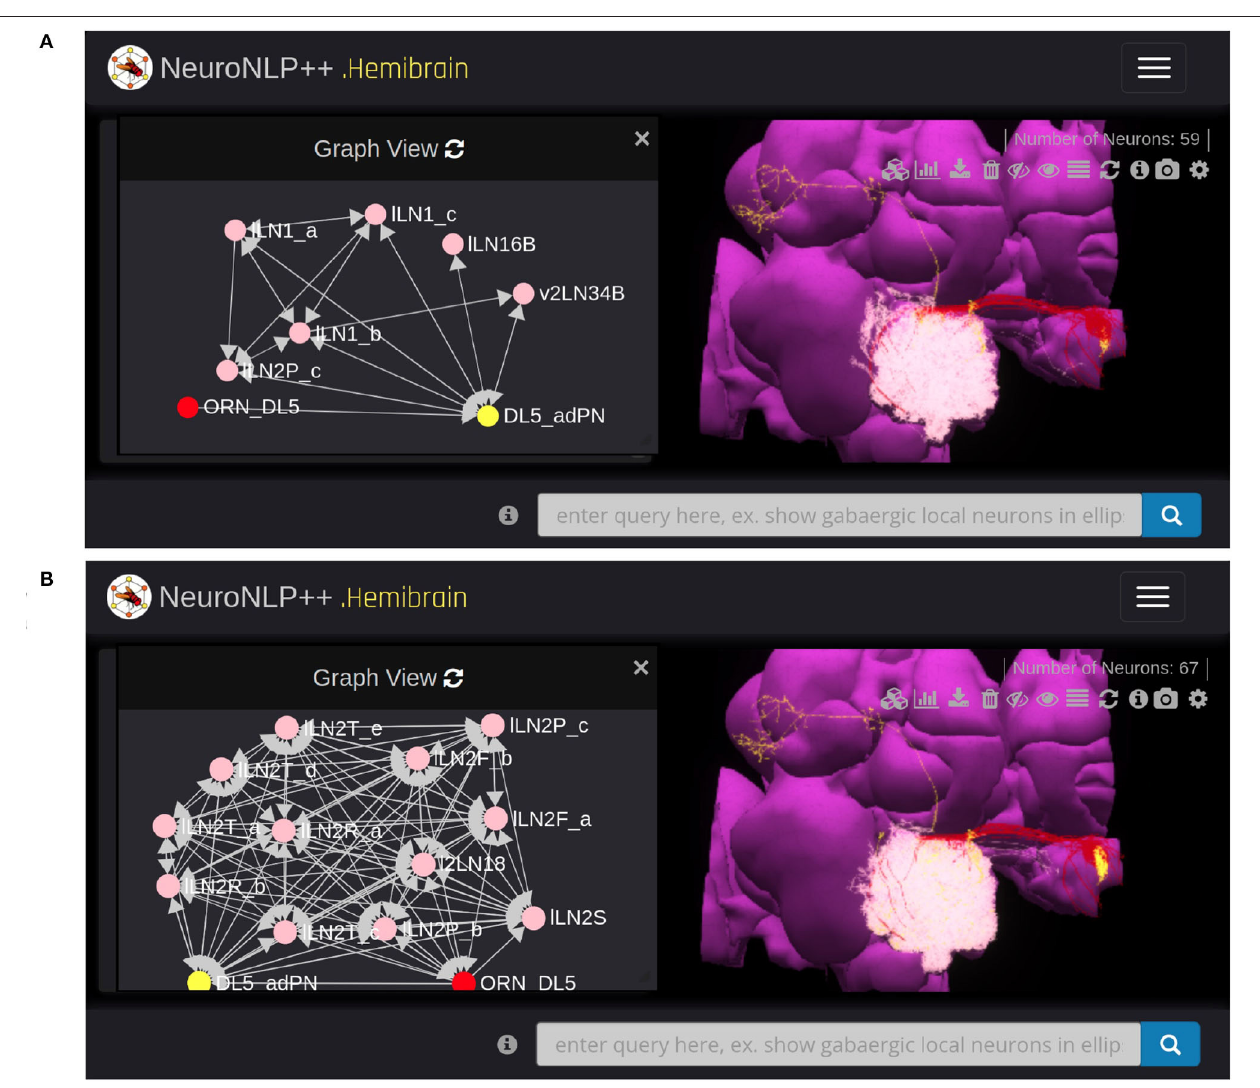
FIGURE 5 | Exploring feedback loops with NeuroNLP ++ . The result to the query “show available feedback loops” when starting from Figure 4A with OSNs with axons that arborize the DL5 glomerulus and PNs with dendrites in DL5 glomerulus. (A) PN-LN-PN feedback loop (receives inputs from and only feeds back to PNs). (red) OSNs. (yellow) PNs. (pink) LNs. (B) OSN/PN-LN-OSN/PN feedback loop (LNs receive inputs from both OSNs and PNs and provide, respectively, feedback to them). (red) OSNs. (yellow) PNs. (pink)